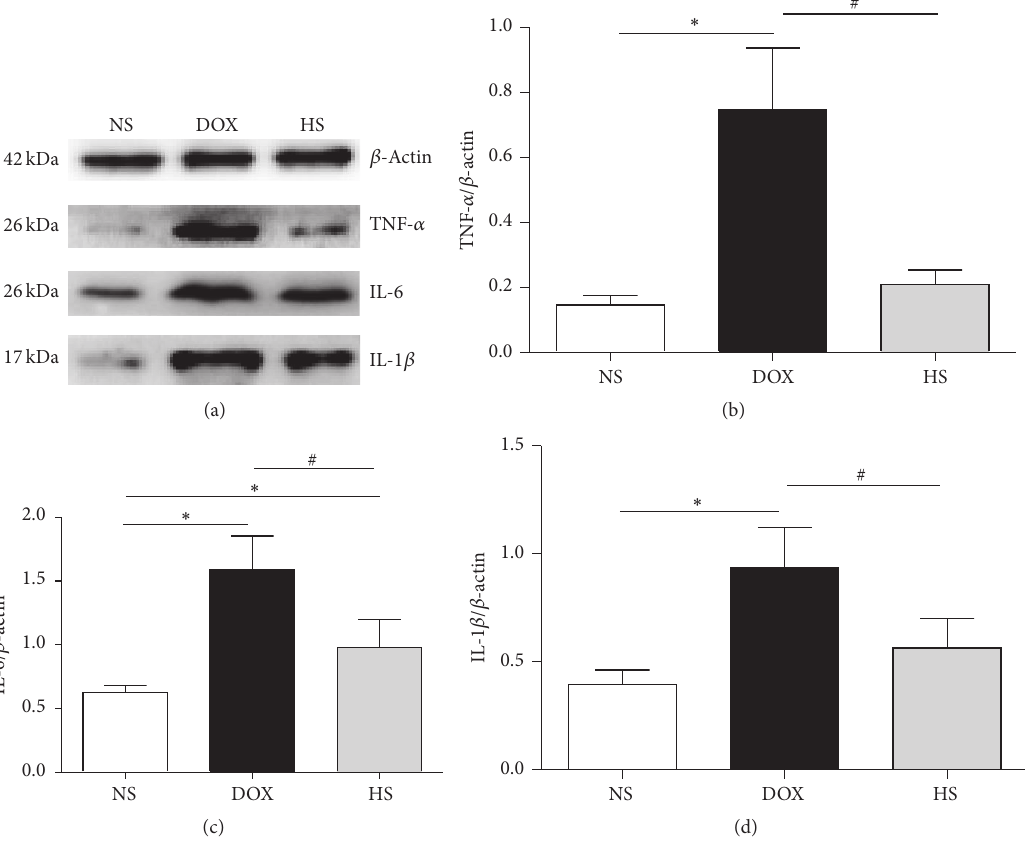
Figure 4: The anti-inflammatory effect of hydrogen-rich saline on cardiac tissue. Representative expression of inflammatory-related proteins in the heart after the treatment was detected (a–d). Data are shown as mean ± SD, 𝑛 ≥ 3 . ∗ 𝑃 < 0.05 versus NS group; # 𝑃 < 0.05 versus DOX